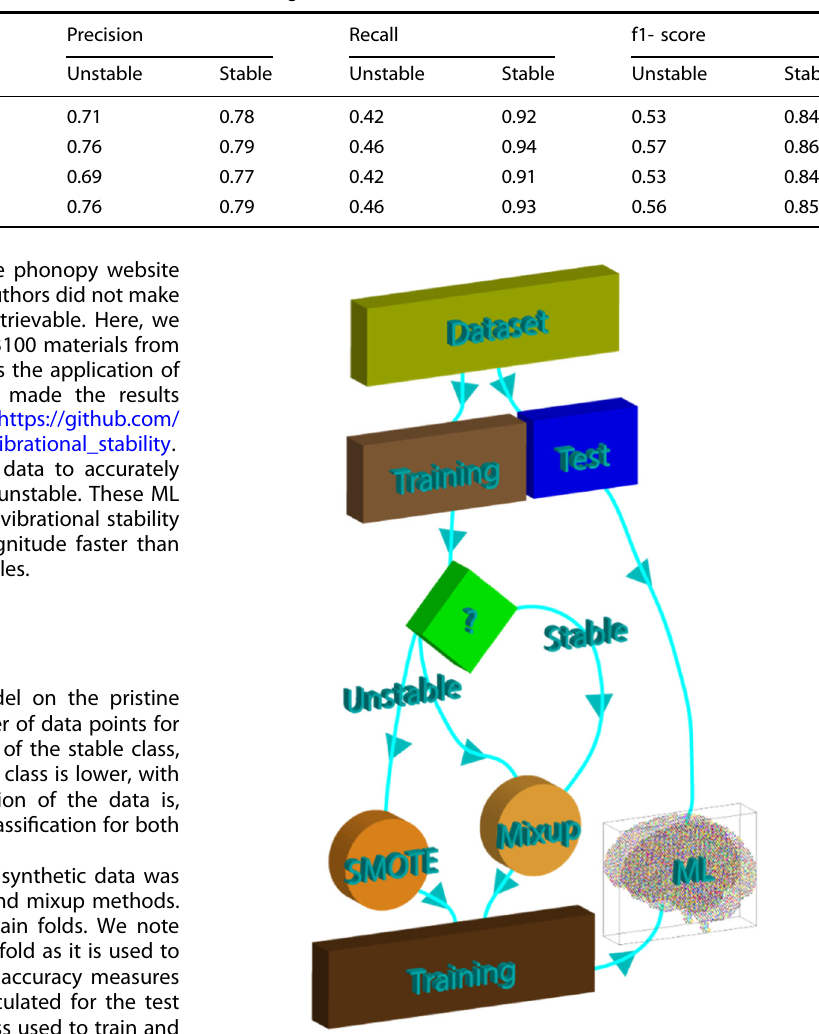
Fig. 1 The machine learning work fl ow. Work fl ow overview for a single iteration of the fi vefold training of the classi fi er model.